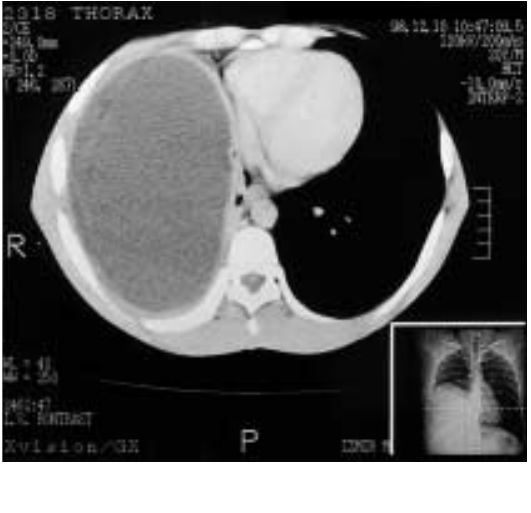
A. Multiple intact and ruptured hydatid cysts removed from pleural space in one patient. B. Multiple intact hydatid cysts in the same